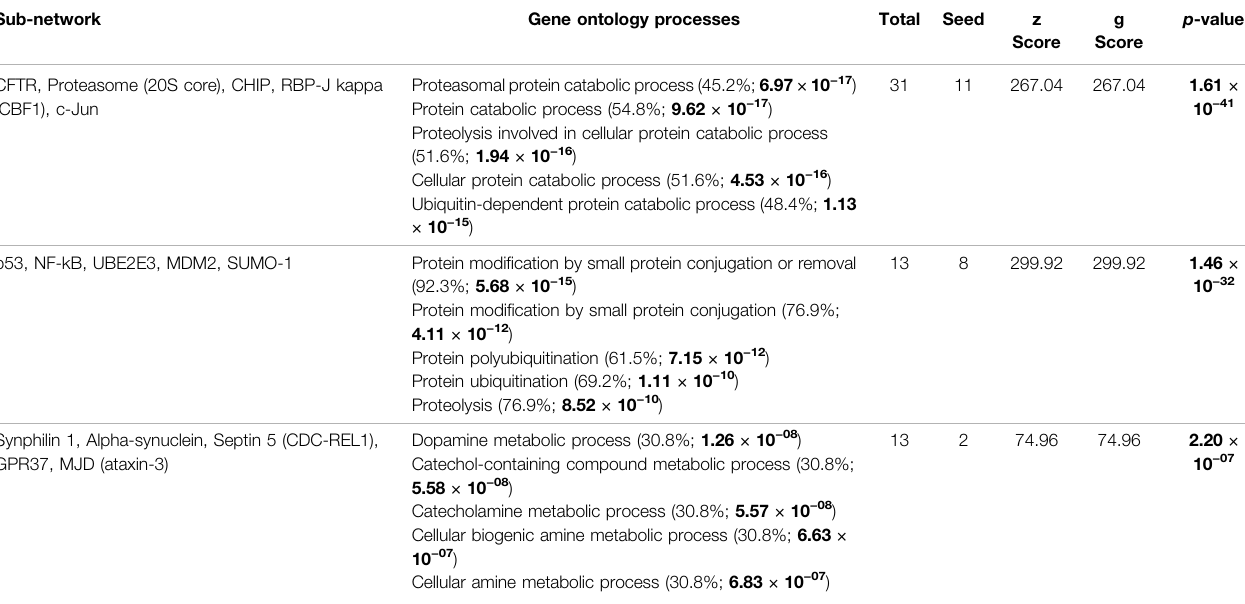
Enrichment analyses were performed by canonical pathway modeling for the differentially expressed genes ( p < 0.050) between the case (SMA) and control (M l MA) groups using MetaCore ™ . Top-ranked gene ontology (GO) processes associated with each subnetwork are shown. Signi fi cant p -values are shown in bold.